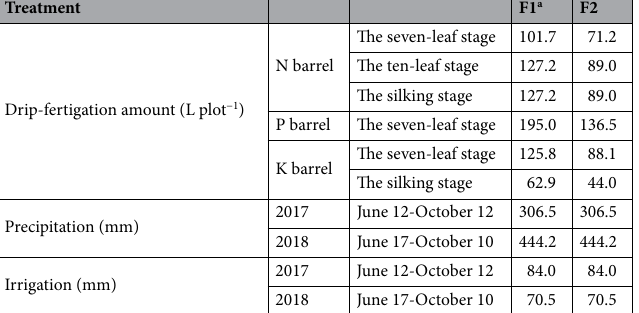
Treatment F1 a F2 N barrel Drip-fertigation amount (L plot −1 )